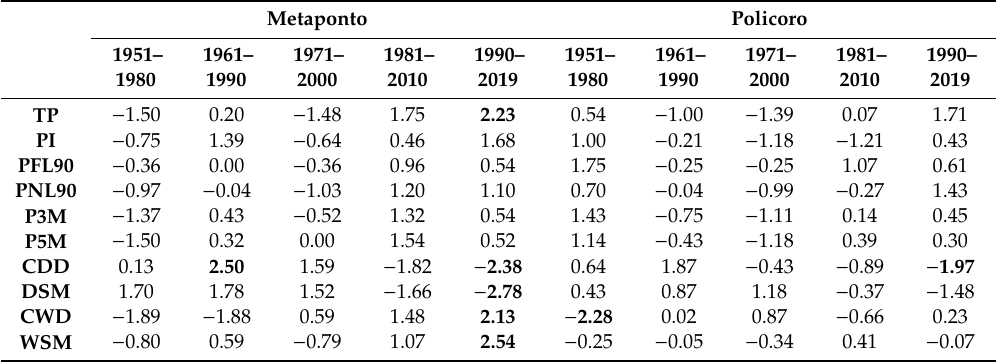
Table 2. Mann–Kendall trend test results (Z value) of the pluviometric indices for the Metaponto and Policoro rain gauge over the period 1951–2019. Bold number indicates statistically significant trend.